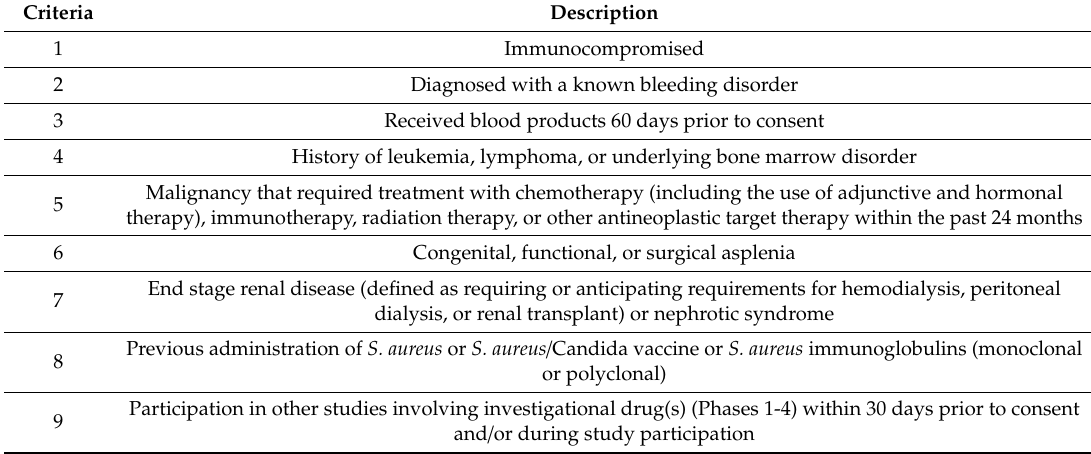
Table 3. Study exclusion